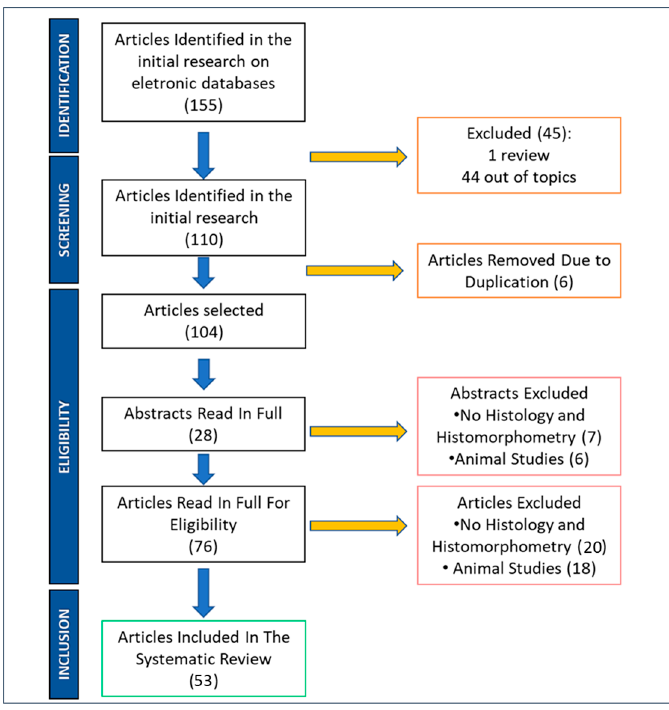
Figure 1. PRISMA Flow chart diagram of the study design and manuscript-selection process .